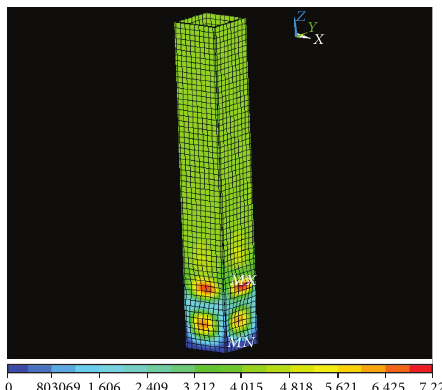
Figure 23: Typical computed deformed shapes of HS-50-20-T1.